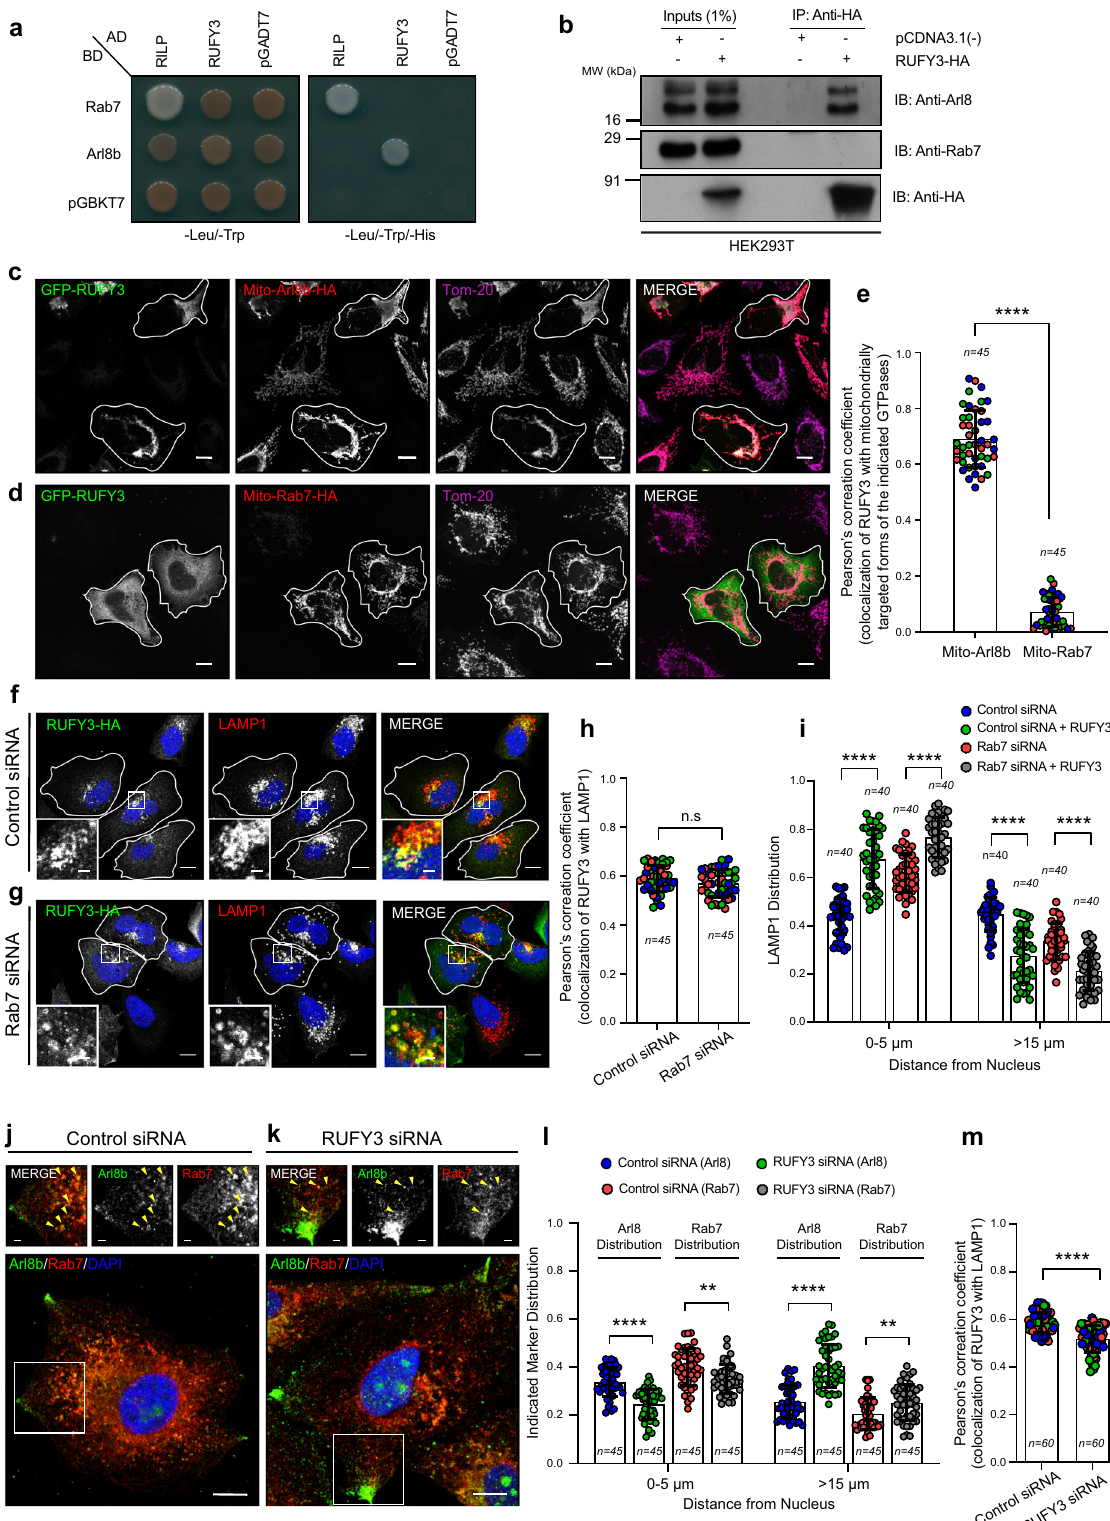
Lysosensor dyes are pH sensitive and are used for ratiometric measurement of the intraorganellar pH of acidic organelles 60 . Surprisingly, while we did not observe any signi fi cant changes in lysosome pH in RUFY3-depleted cells (5.63 ± 0.19), as compared to control cells (5.49 ± 0.18) (Fig. 7a, b), there was a two-fold reduction in Lysotracker intensity in RUFY3-depleted cells, as